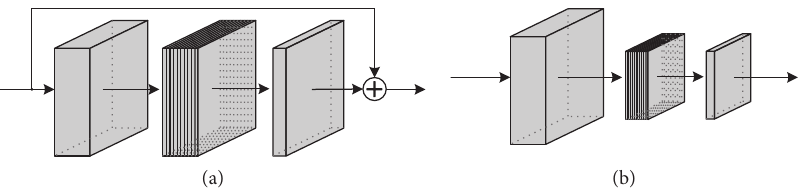
Figure 4: Structures of bottleneck layer unit with variant stride in group convolution. The first and the third convolutions in above structure are point convolution, while the second is group convolution. (a) Bottleneck with skip connection and stride of 1. The symbol “ ⊕ ” represents elementwise summation. (b) Bottleneck with stride of 2.